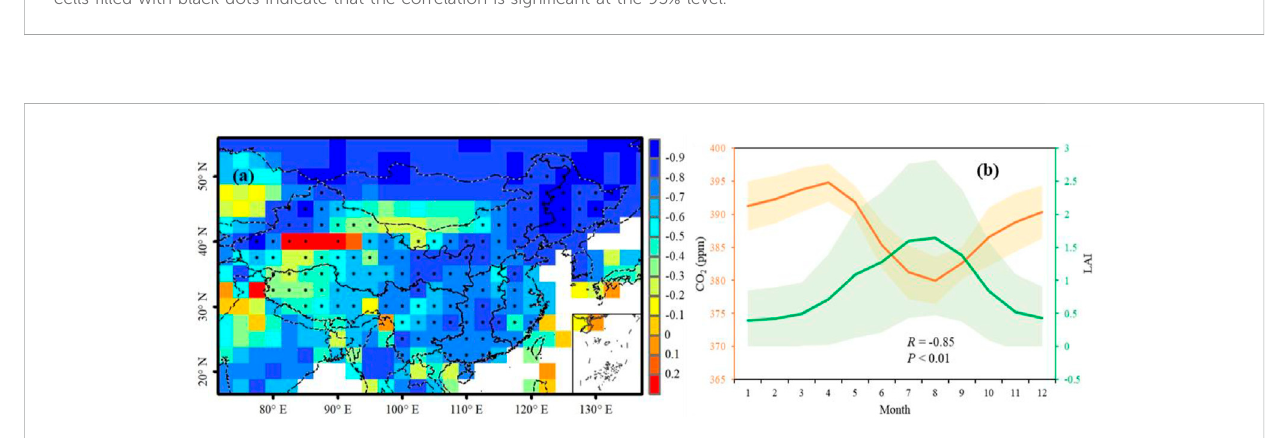
FIGURE 11 Correlation analysisbetweenCO 2 and fossil fuel carbon emissionson the grid (A) and national scale (B) atnear surface. It isto benoted that the grid cells fi lled with black dots indicate that the correlation is signi fi cant at the 95% level.